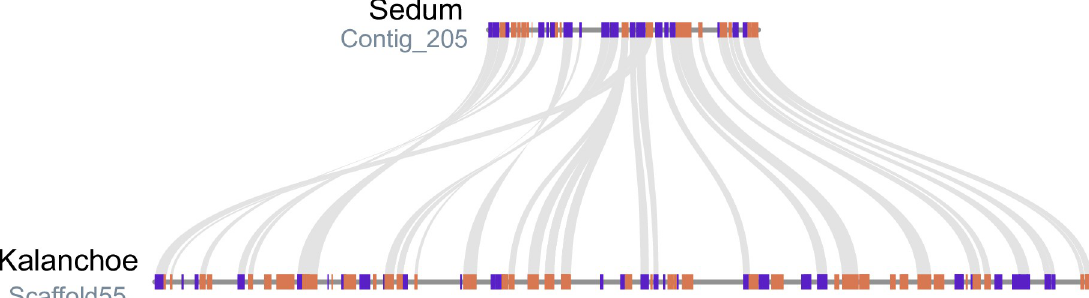
Fig 1. Comparative genomics between the S . album and K . fedtschenkoi genomes. Microsynteny between syntenic blocks of the S . album (top) and K . fedtschenkoi (bottom) genomes. Syntenic gene pairs are shown by gray connections and genes are colored by orientation with blue and orange representing forward and reverse orientation respectively. The plotted region in Sedum spans 0.06–0.17 Mb on Contig_205 and 2.42–2.83 Mb on Scaffold55 in K . fedtschenkoi .